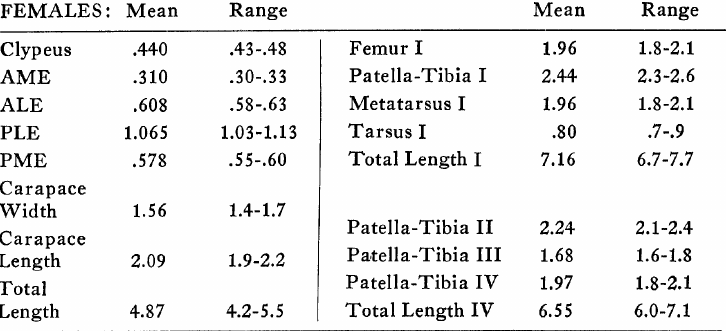
Figs. 31-32. Oxyopes summus new species, female from Gamboa, Pan- ama Canal Zone, 24 July 1954. 31. Internal genitalia. 32. Epigynum. Figs. 33-34. Oxyopes chiapas new species, female from La Zaeualpa, Chiapas, Aug. 1909. 33. Internal genitalia. 34. Epigynum. Figs. 35-36. Oxyo#es tibialis F.O.P.-Cambridge, female from Musawas on Waspue River, Nicaragua, 10-31 Oct. 1955. 35. Internal genitalia. 36. Epigynum. Figs. 37-38. Oxyopes bifissus F.O.P.-Cambridge, female from Tama- zunehale, San Luis Potosi, 19 April 1963. 37. Internal genitalia. 38. Epigy-